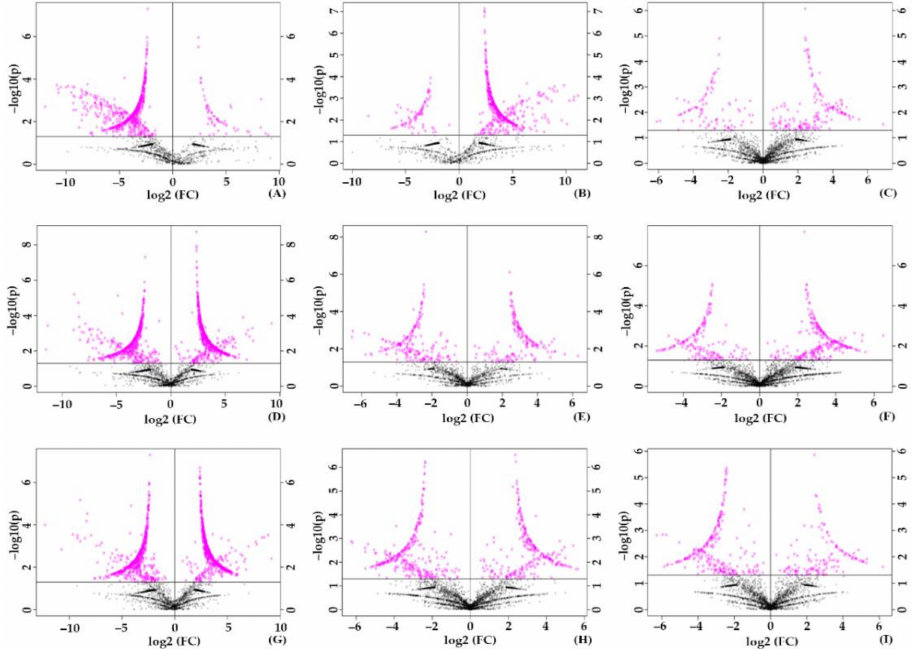
Figure 6. Volcano plot of significant metabolites during SA stress. ( A ) Control vs. treated_1. ( B ) Treated_1 vs. treated_2. ( C ) Treated_2 vs. treated_3. ( D ) Control vs. treated_4. ( E ) Treated_4 vs. treated_5. ( F ) Treated_5 vs. treated_6. ( G ) Control vs. treated_7. ( H ) Treated_7 vs. treated_8. ( I ) Treated_8 vs.